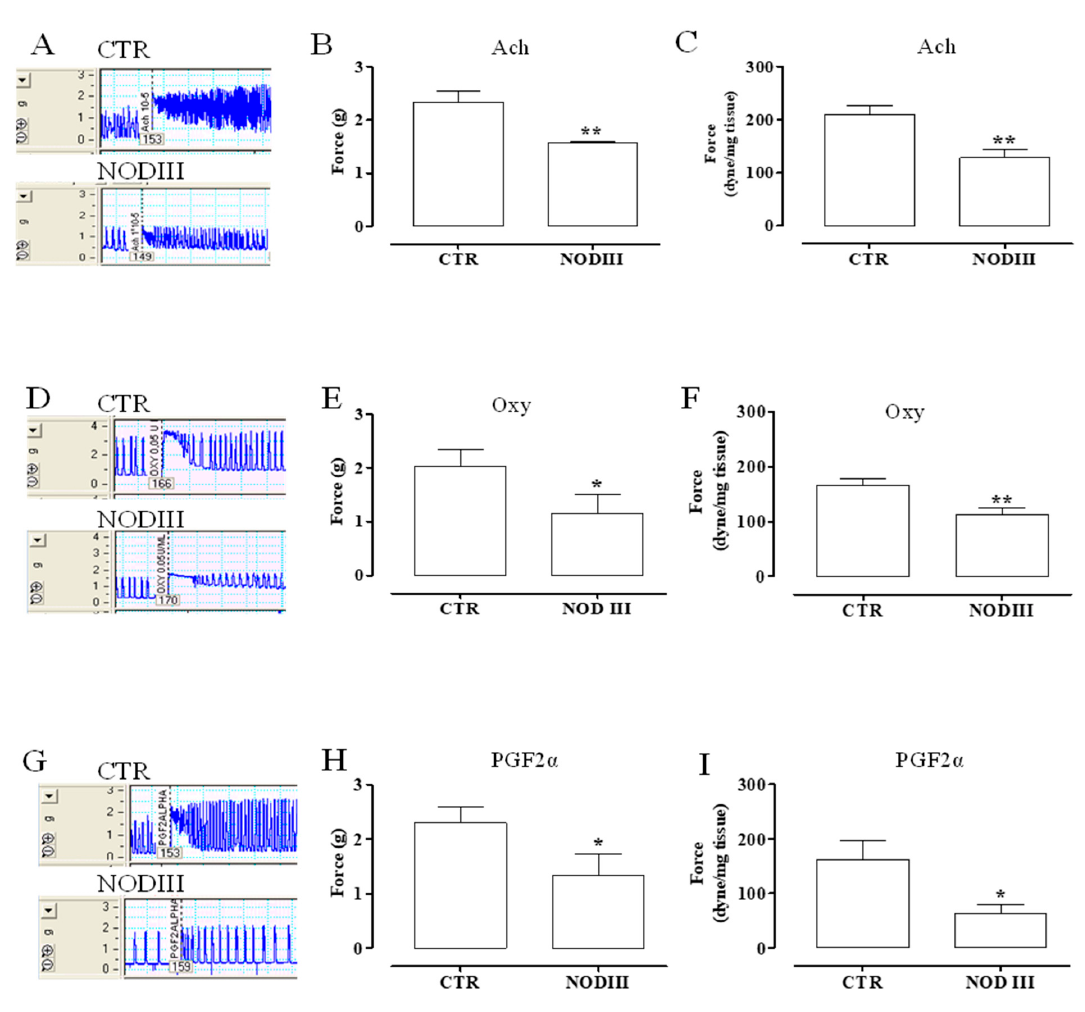
Figure 3. UterineresponsetocontractingagentsinNODIIImice. ( A )showsatypicaltracerofAch-induced contraction of uteri harvested from either CTR or NODIII mice. The contractile response to Ach (10 µ M) is shown as gram ( B ) or dyne / mg tissue ( C ). It is significantly reduced in NODIII mice vs. CTR mice (** p < 0.01). ( D ) shows a typical tracer of Oxy-induced contraction of uteri harvested from CTR or NODIII mice. The contractile response to Oxy (0.005 U / mL) is reported as gram ( E ) or dyne / mg tissue ( F ), and it is significantly reduced in NODIII mice vs. CTR mice (* p < 0.05, ** p < 0.001, respectively). ( G ) shows a typical tracer of PGF2 α -induced contraction of uteri harvested from CTR or NODIII mice. The contractile response to PGF2 α (0.1 µ M) is shown as gram ( H ) or dyne / mg tissue ( I ), and it is significantly reduced in NODIII mice vs. CTR mice (* p < 0.05). Results are calculated as mean ± SEM ( n = 6 mice) and analyzed by unpaired Student’s t